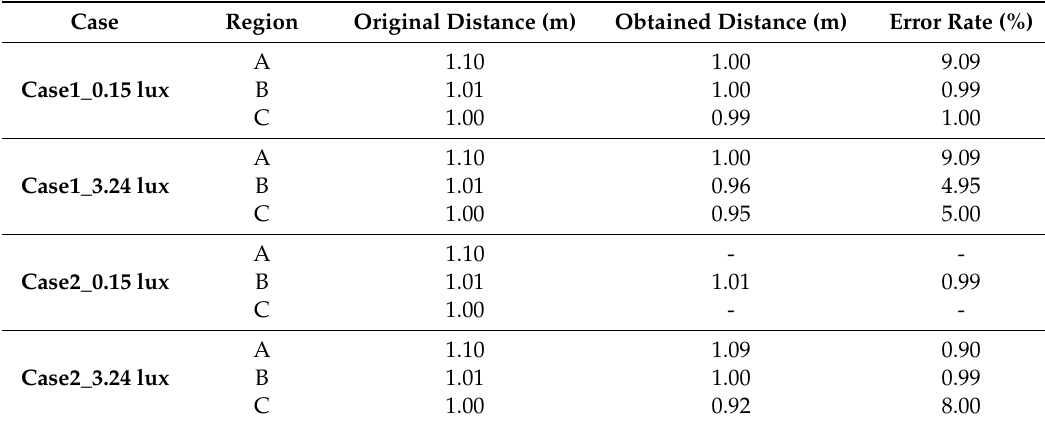
Figure 28. Results of increasing contrast in images of the ship model measured in the out-of-water environment with illuminance of ( a ) 0.15 lux and ( b ) 3.24 lux; and in the underwater environment of 1.1 NTU turbidity with illuminance of ( c ) 0.15 lux and ( d ) 3.24 lux, respectively. Table 13. Measured results after the contrast had been increased (error rate (%) = ( |original distance − obtained distance| )/(original distance) × 100%).